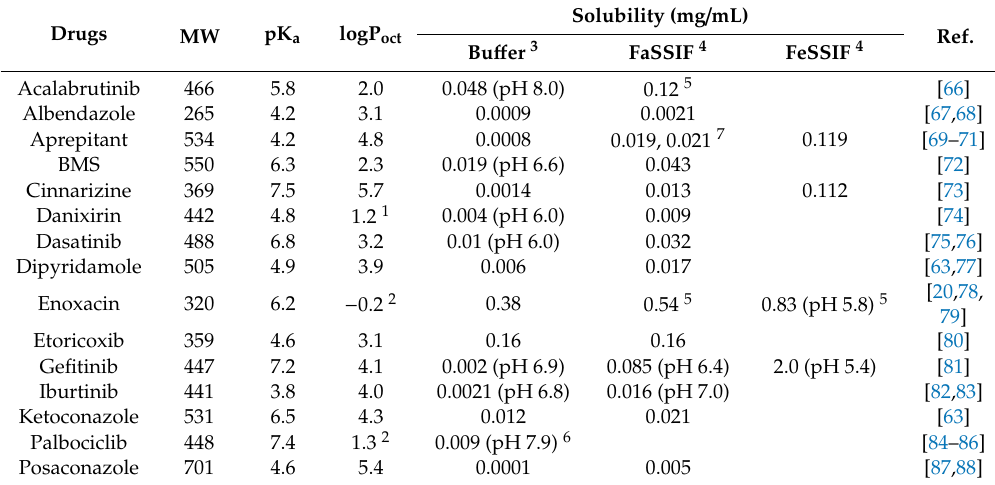
Table 2. Physicochemical properties of free weak base